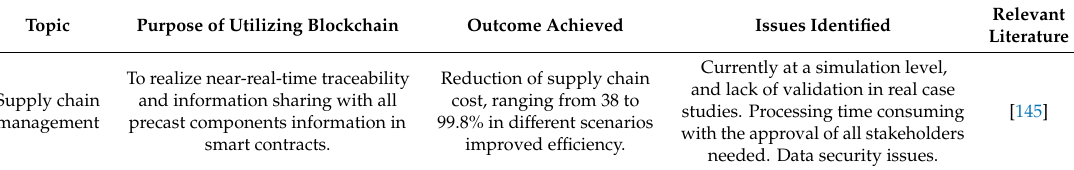
Table 18. Research topics, purpose of blockchain adoption, and outcomes achieved in previous studies.